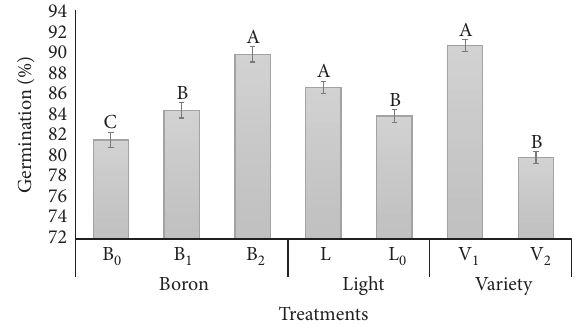
Figure 1: Effect of boron and light on germination percentage of two peanut varieties (mean of two trials). B = boron; L = light; V = variety; B 0 = 0 kgBha −1 , B 1 = 1kg Bha −1 , B 2 = 2 kg Bha −1 , L = normal day light + 6 h extended red light at night ( ≈ 18h light), L 0 = normal day light ( ≈ 12h light), V 1 = Dhaka-1, and V 2 = BARI Chinabadam-8. Means were separated by Tukey’s test at 𝑃 ≤ 0.05 . Vertical bars represent the standard error of the means. A, B, and C are statistically significant among the treatment